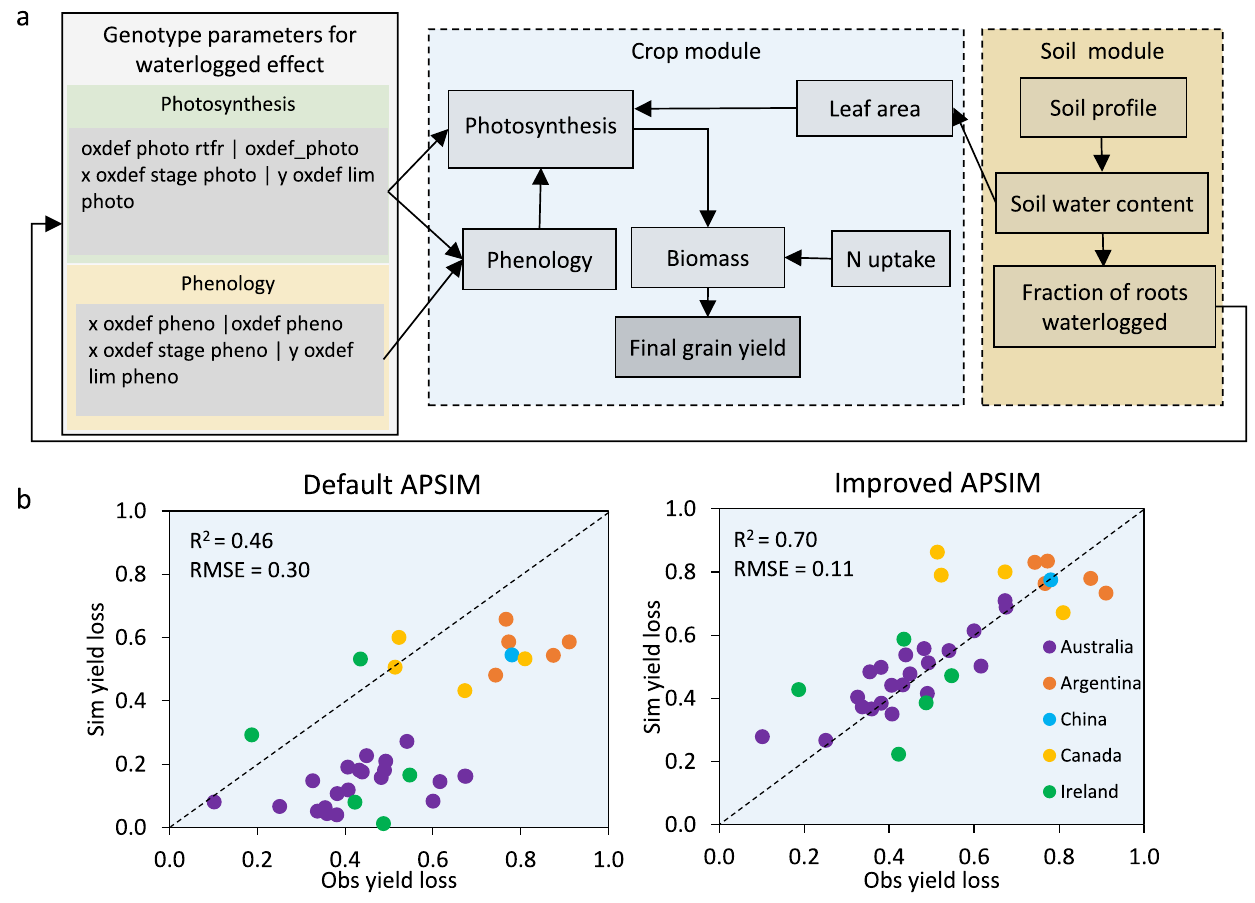
Fig. 1 | Framework invoked for modelling waterlogging (WL) stress, including conceptualdesignofcropphysiologicalresponsestowaterloggingandmodel evaluation before (default) and after (improved) modi fi cation. a Schematic of genotypictraitsin fl uencedbywaterloggingandlinkagewithexistingsoilandwater sub-models in APSIM. b Comparison of observed (Obs) and simulated (Sim)